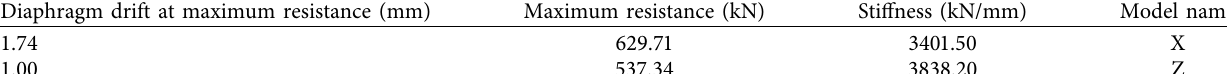
Table 4: Reaction of lateral force-displacement of the diaphragm without opening.